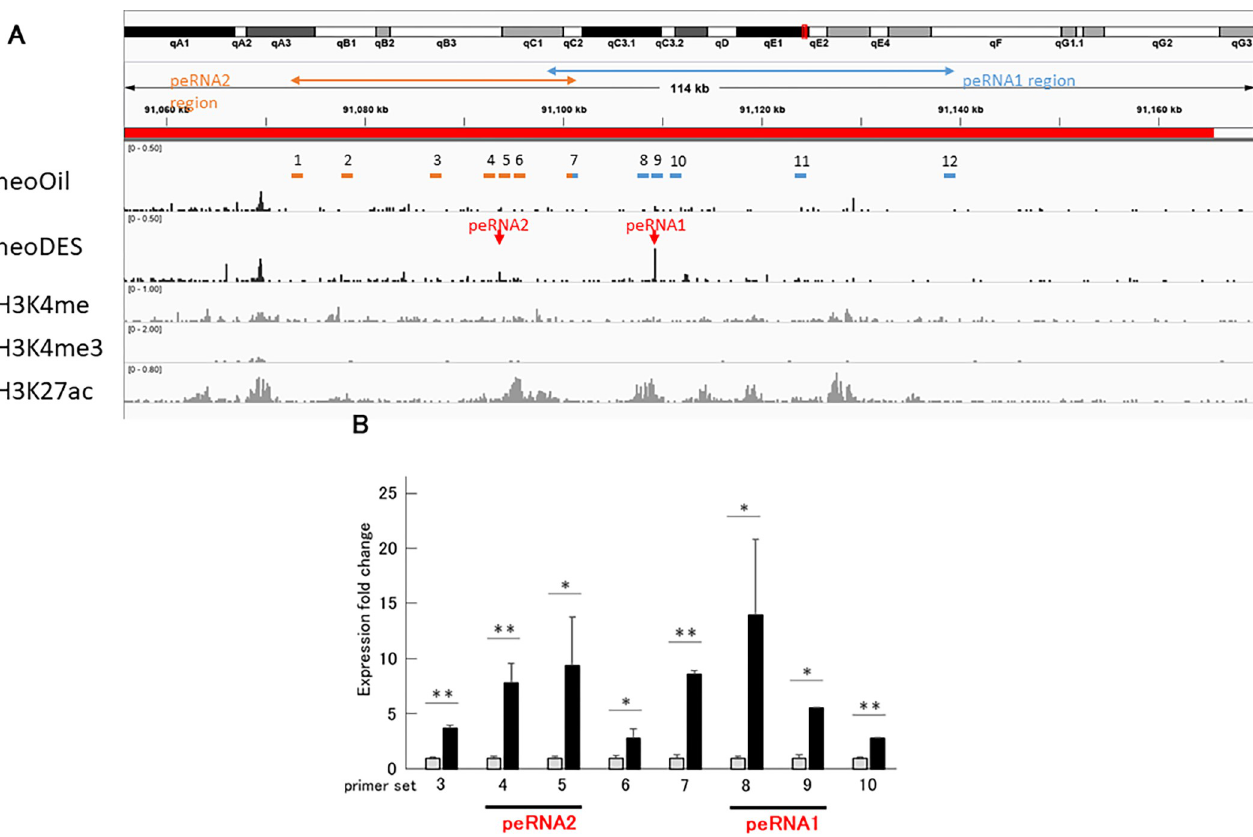
Fig 4. DES-induced changes in the expression of putative eRNAs in the vaginal epithelium. (A) IGV Screen Shot of CAGE results showing designed 12 primer sets. The location of the primer sets is indicated. Two arrows in red show peaks of CAGE reads we detected in neoDES but not in neoOil. Information on placenta histone modification patterns, including H3K4m1, H3K4m3, and H3K27a are shown. See S3 Fig for more details. (B) Expression fold change between neoOil (gray) and neoDES (black) in the epithelium. Results of qPCR analysis with primer sets indicated are shown (n = 3; t-test, � p < 0.05, �� p < 0.01). Peaks of CAGE reads corresponding to peRNA1 and peRNA2 are present near the primer sets indicated with horizontal lines,